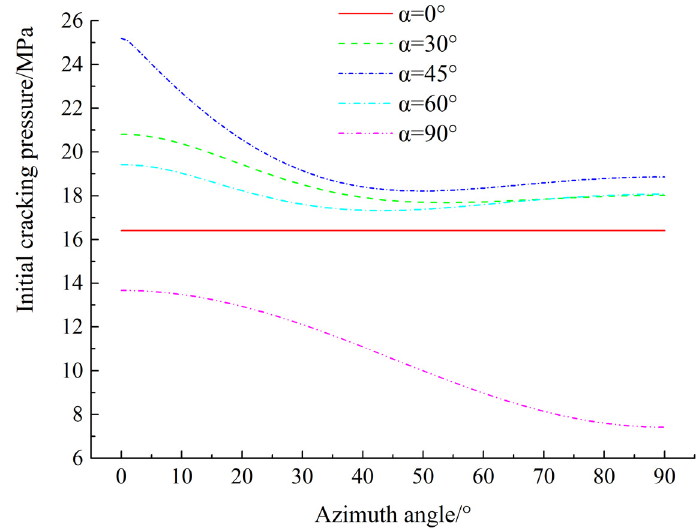
Figure 13. Relationship between the initial cracking pressure and the major principle stress azimuth